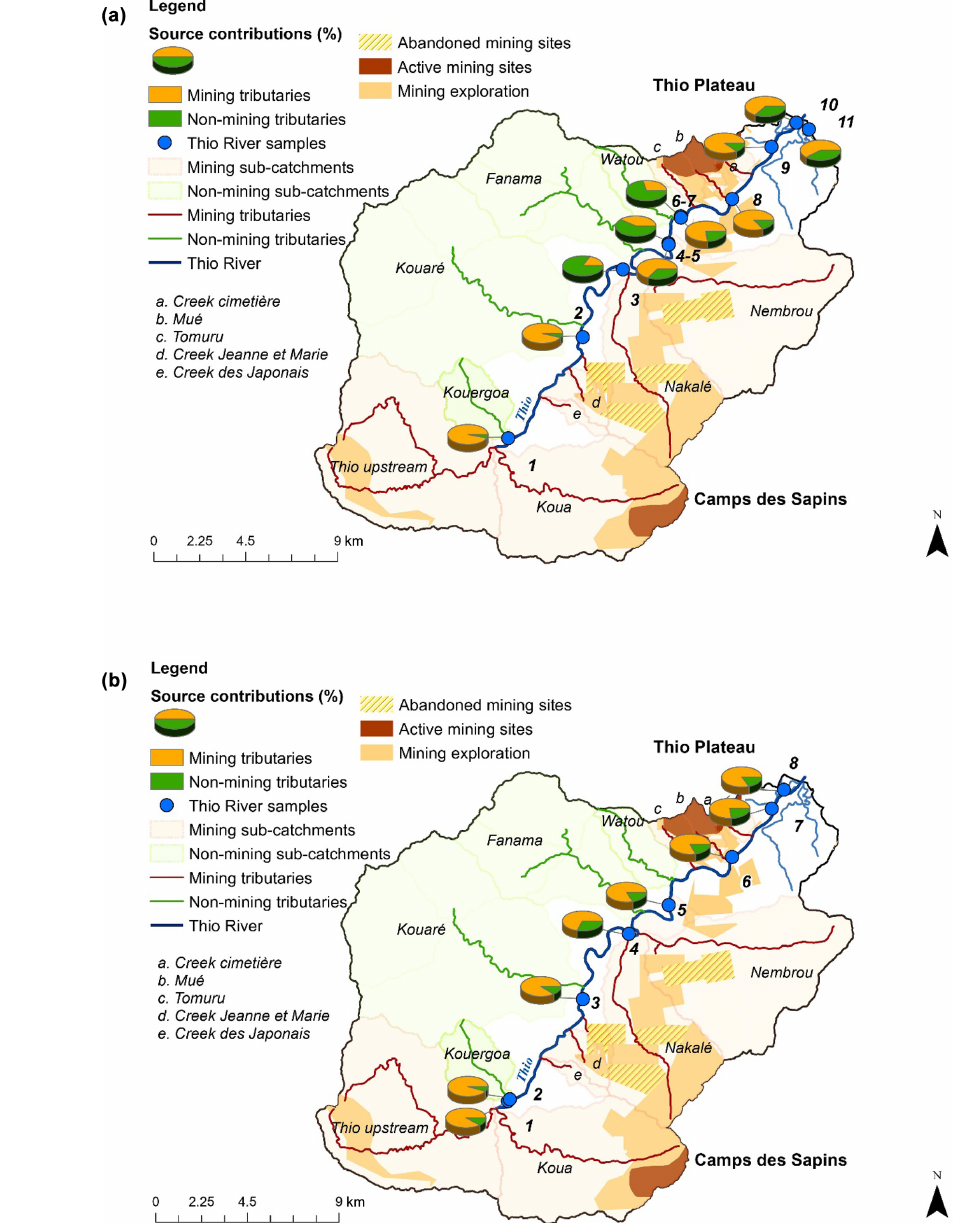
Figure 8. Relative contributions of mining and non-mining tributaries to the sediment collected in the Thio River during the 2015 (a) and 2017 (b) flood events using the geochemistry